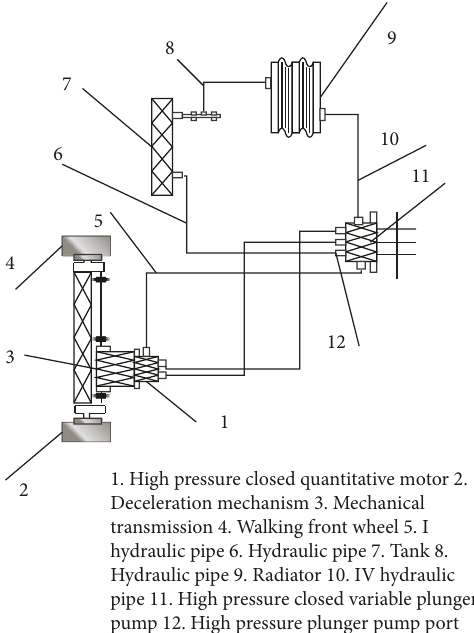
Figure 8: Schematic diagram of the hydrostatic drive system of the drive chassis.